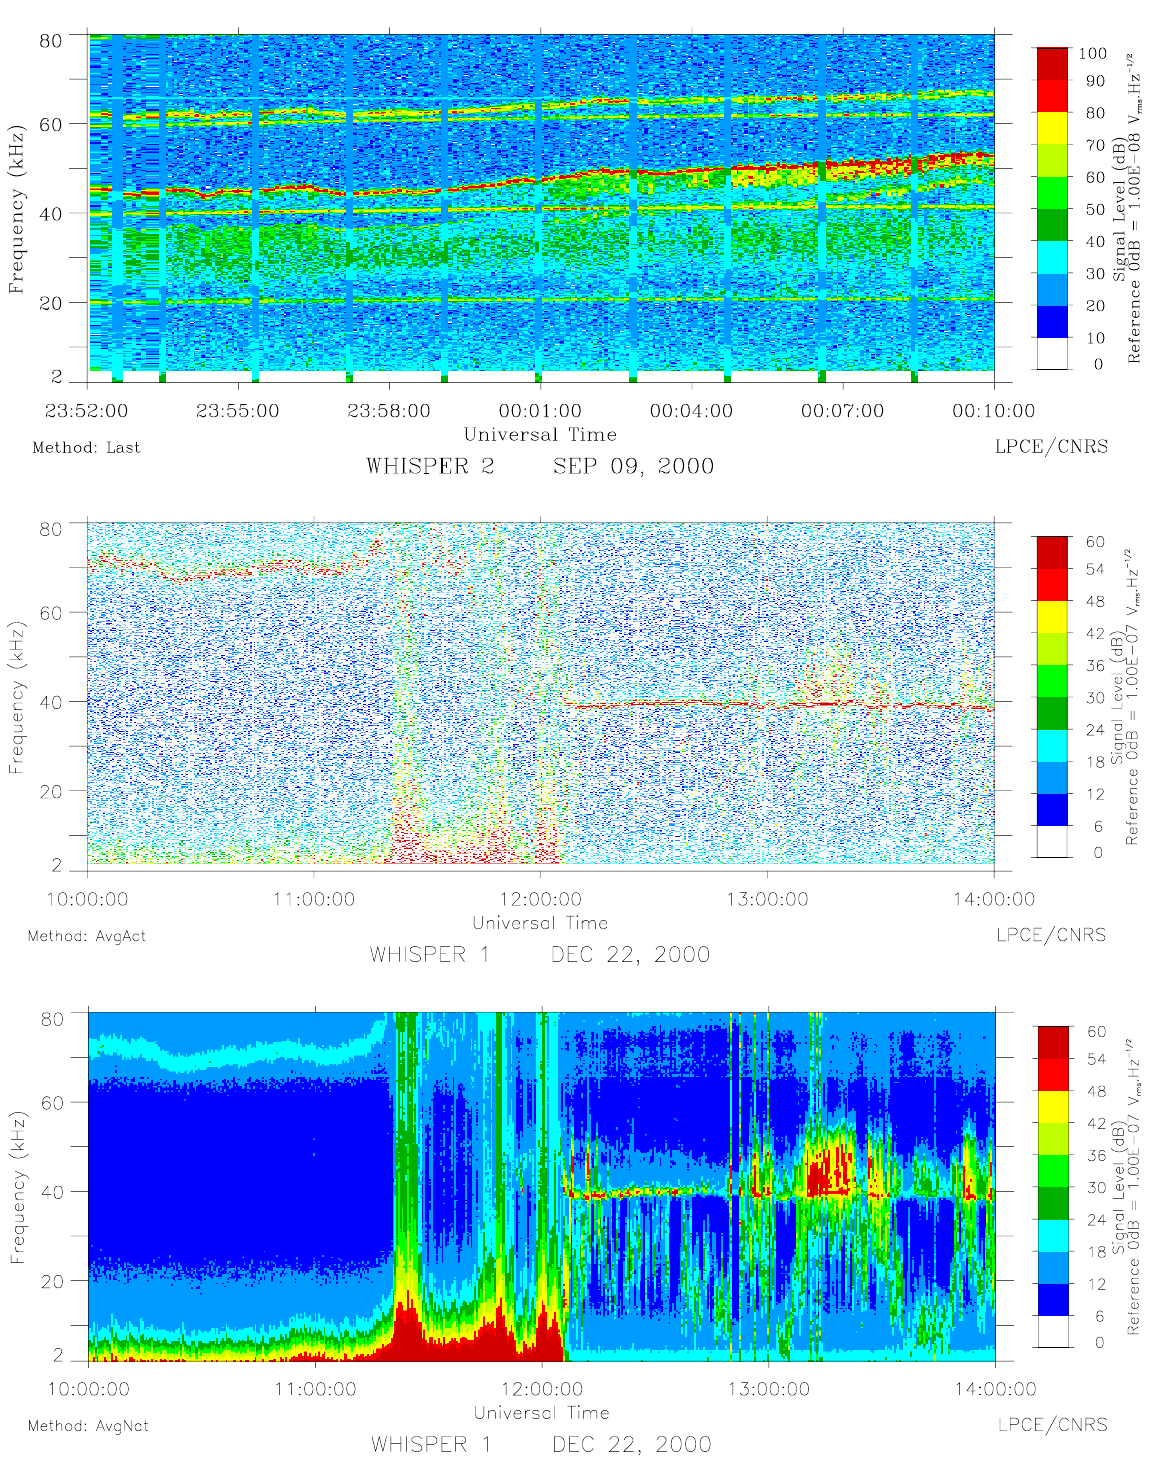
Fig. 2. Dynamic spectrograms of the electric field measured by the Whisper relaxation sounder on board Cluster-2 in the Earth’s magneto- sphere (top panel) and on board Cluster-1 during a magnetosheath-solar wind pass (middle and bottom panels). Active spectra are displayed in the top two panels, while passive spectra are shown in the bottom